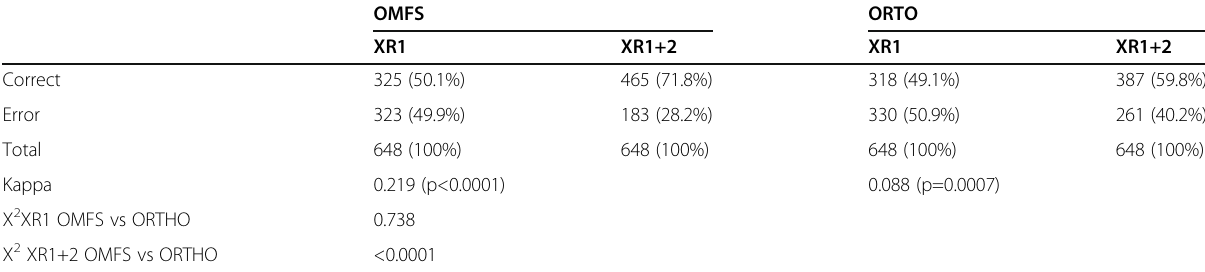
Table 4 Frequency and difference (X 2 ) of the responses indicated by oralmaxillofacial surgeons (OMFS) and orthodontists (ORTHO) when evaluating impacted lower third molars (n=24) after analysis of one (XR1) or two serial radiographs